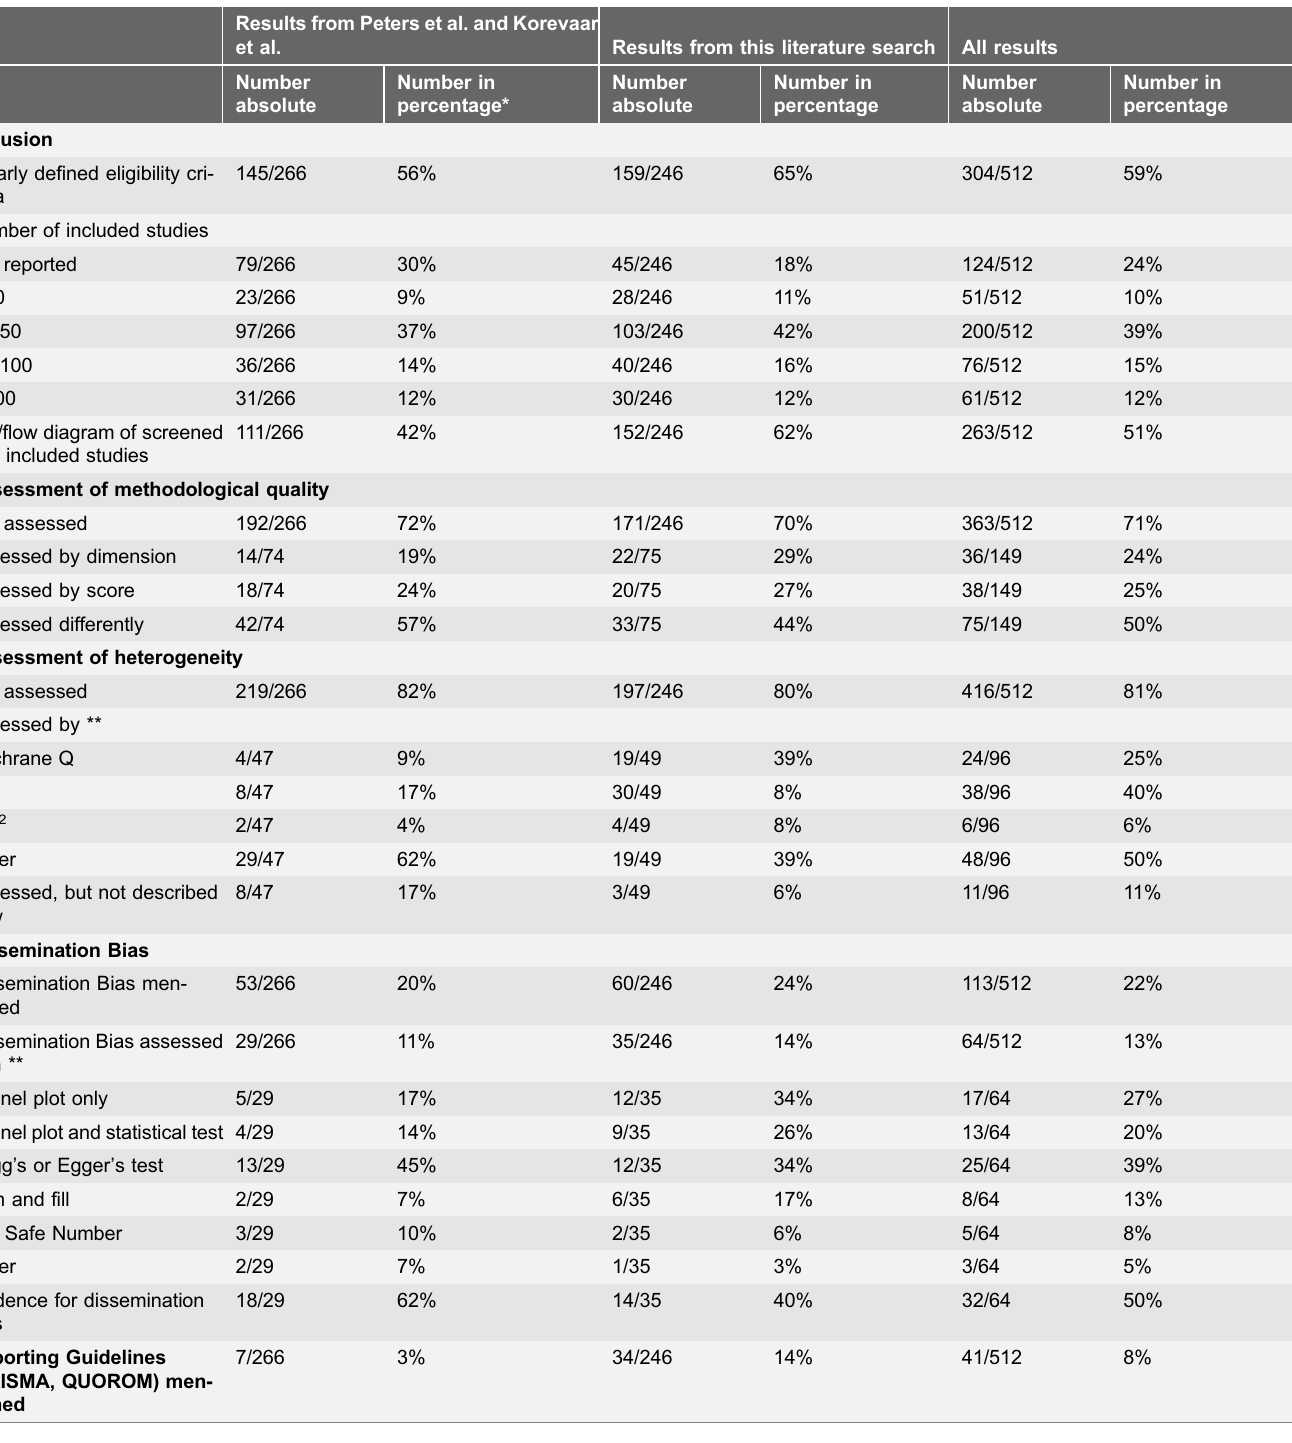
Table 2. Methodological features of included systematic